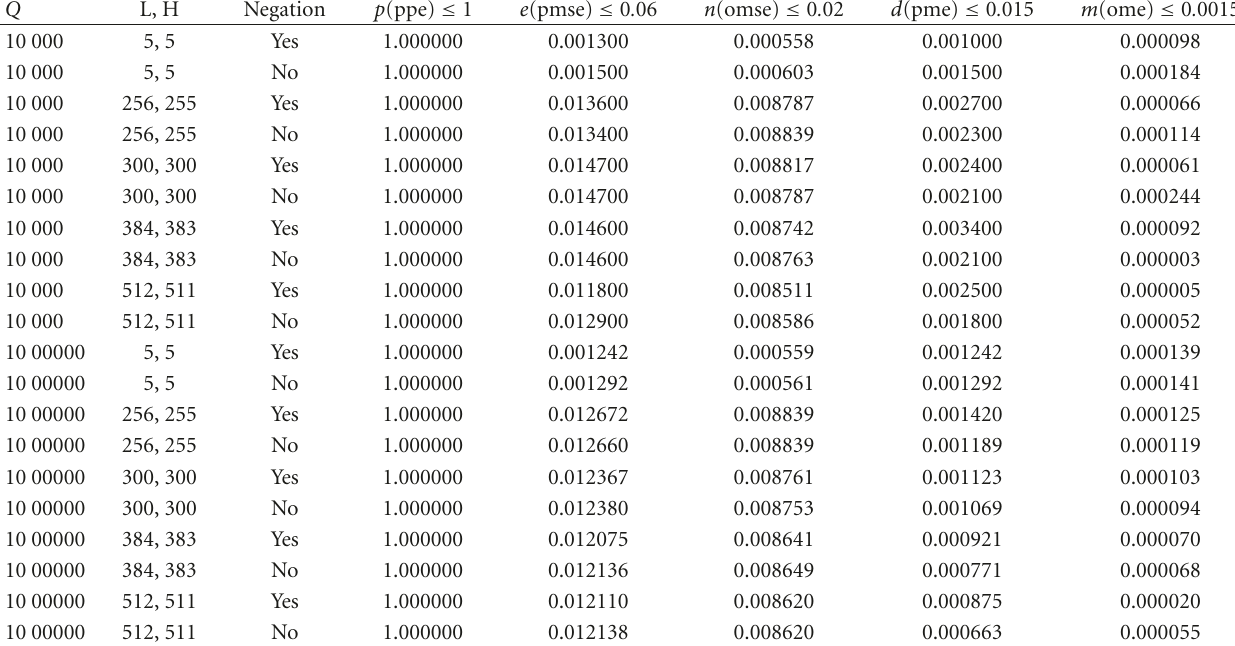
Table 4: IDCT precision performance for 24-bit or 1-bit